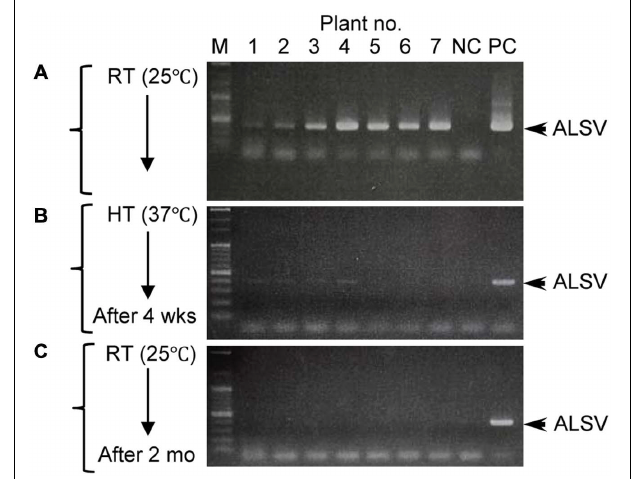
FIGURE 5 | RT-PCR detection of ALSV from pear seedlings before and after high-temperature treatment. (A–C) Detection of ALSV from pear seedlings grown at 25 ◦ C (A) , then grown at 37 ◦ C for 4 weeks (wks; B ), and transferred to 25 ◦ C and grown for 2 months (mo; C